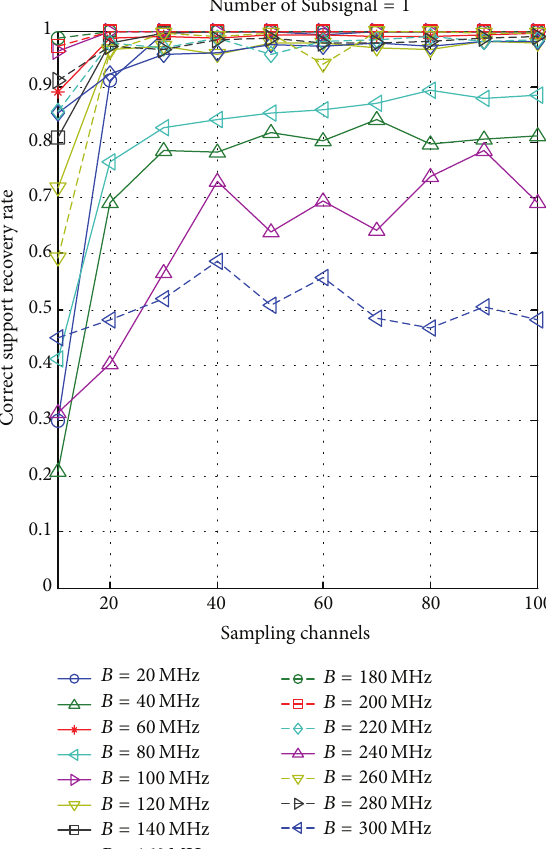
Figure 4: Recovery performance with one